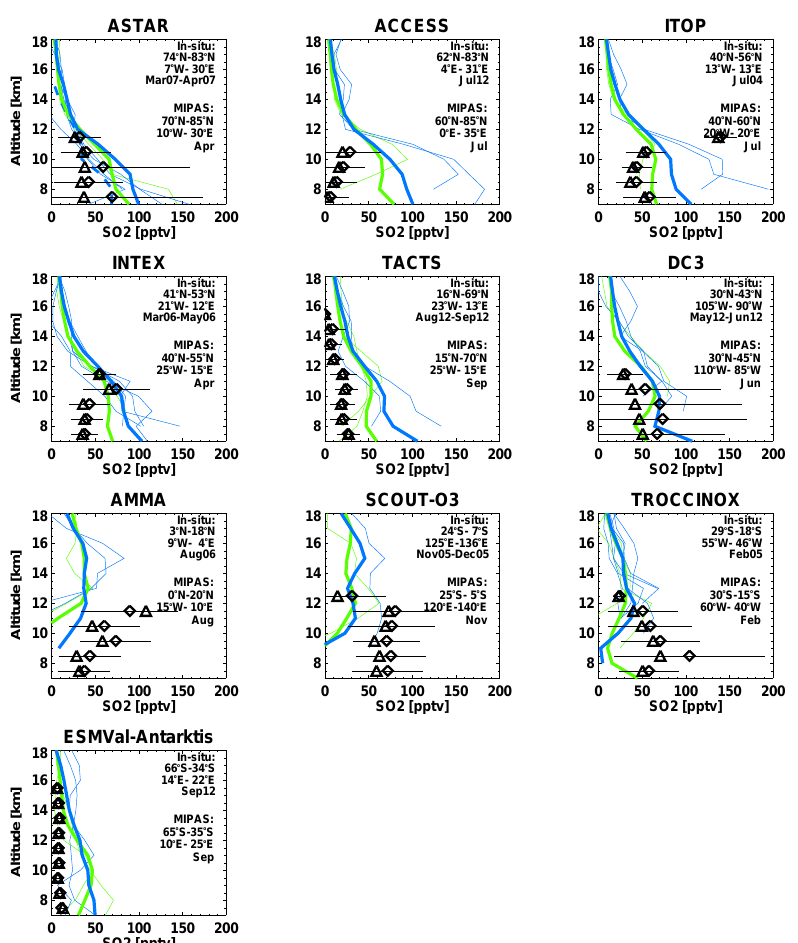
Figure 8. Comparison between in situ airborne ITCIMS observations and the debiased MIPAS data set of SO 2 . Green lines indicate MIPAS measurements before April 2004 and blue lines after January 2005 (solid thin lines: monthly mean for each year, solid bold lines: mean of all profiles, dashed bold lines: monthly mean for year of in situ observation). Black diamonds and horizontal bars show the mean values of the in situ observations as well as their 1 σ variability. The median value of the in situ measurements is indicated by black triangles. Periods with strong volcanic influence have been excluded from the MIPAS data (see caption of Fig.